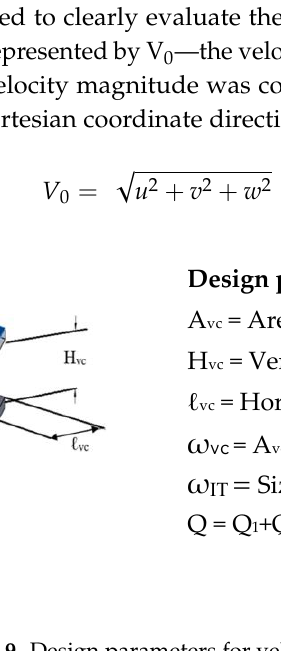
Figure 9. Design parameters for velocity cap.